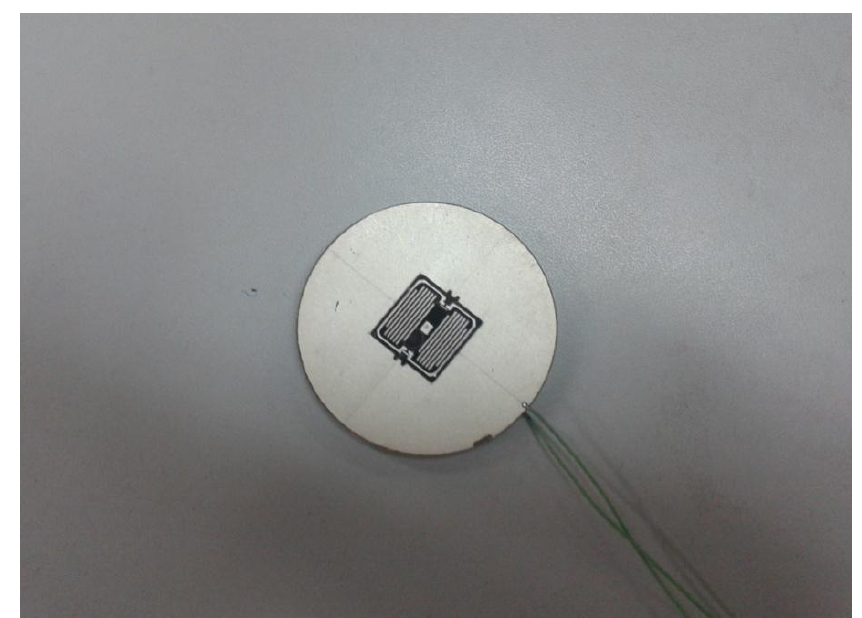
Figure 12. Picture of the